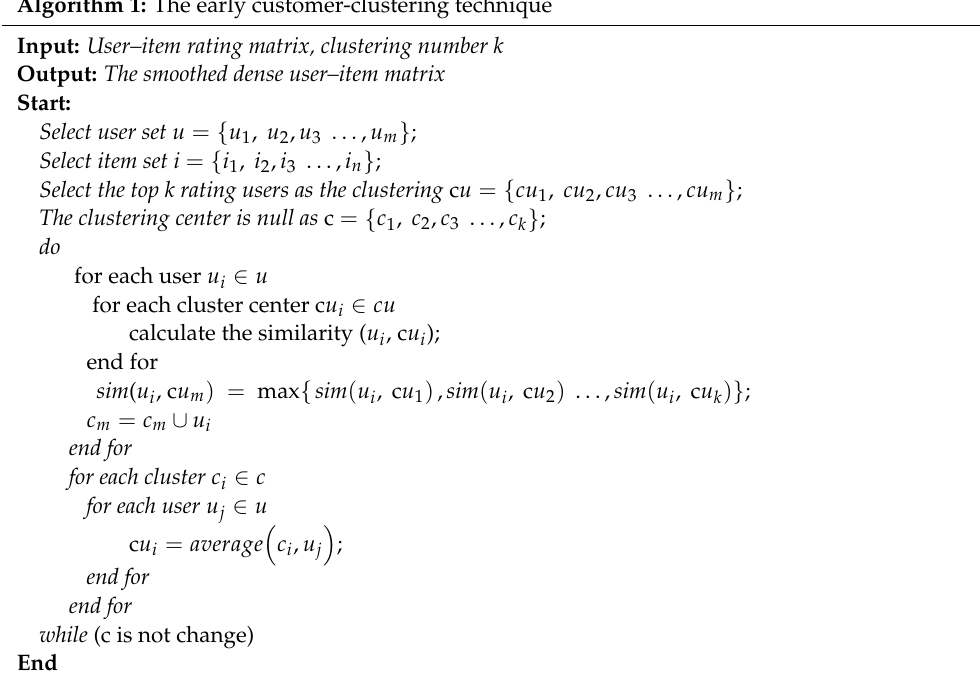
Algorithm 1: The early customer-clustering technique